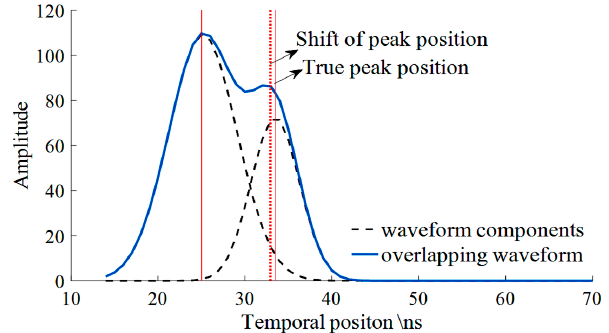
Figure 10. Shift of peak position caused by overlap.